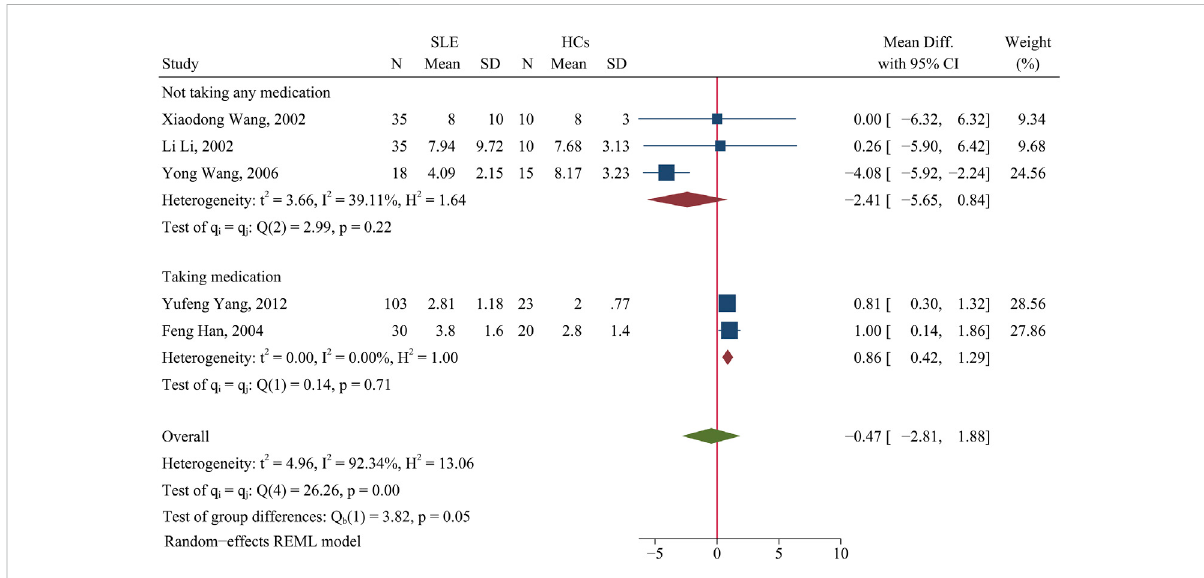
FIGURE 4 Forest plot of the ratio change of Th1/Th2 cells in SLE patients compared with HCs. The overall results (bottom) show the meta-analysis of 5studies,andthetwootherresultsshowmeta-analysesofsubgroupsaccordingtomedicationuse.SLE,systemiclupuserythematosus;HCs,healthy